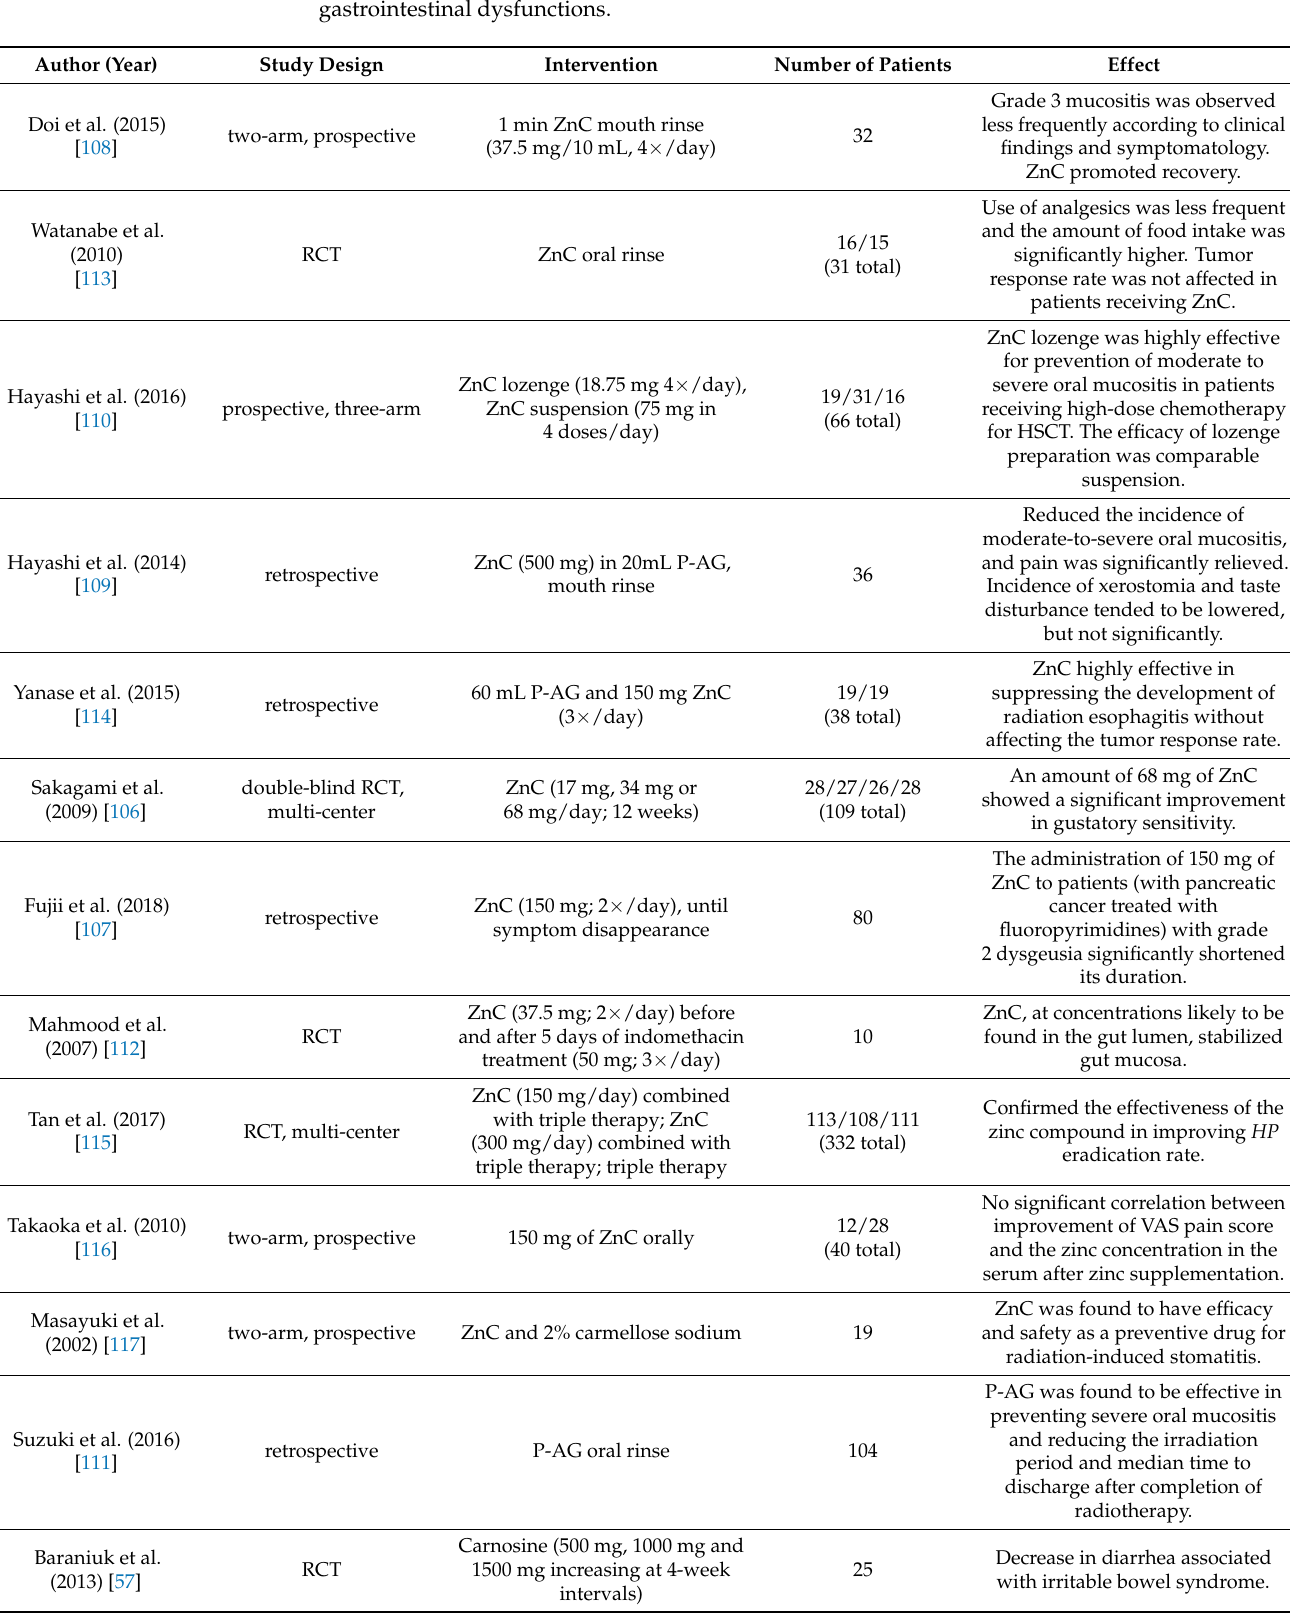
Table 5. The effects of carnosine on oral mucositis, taste disorders, gastritis and gastrointestinal